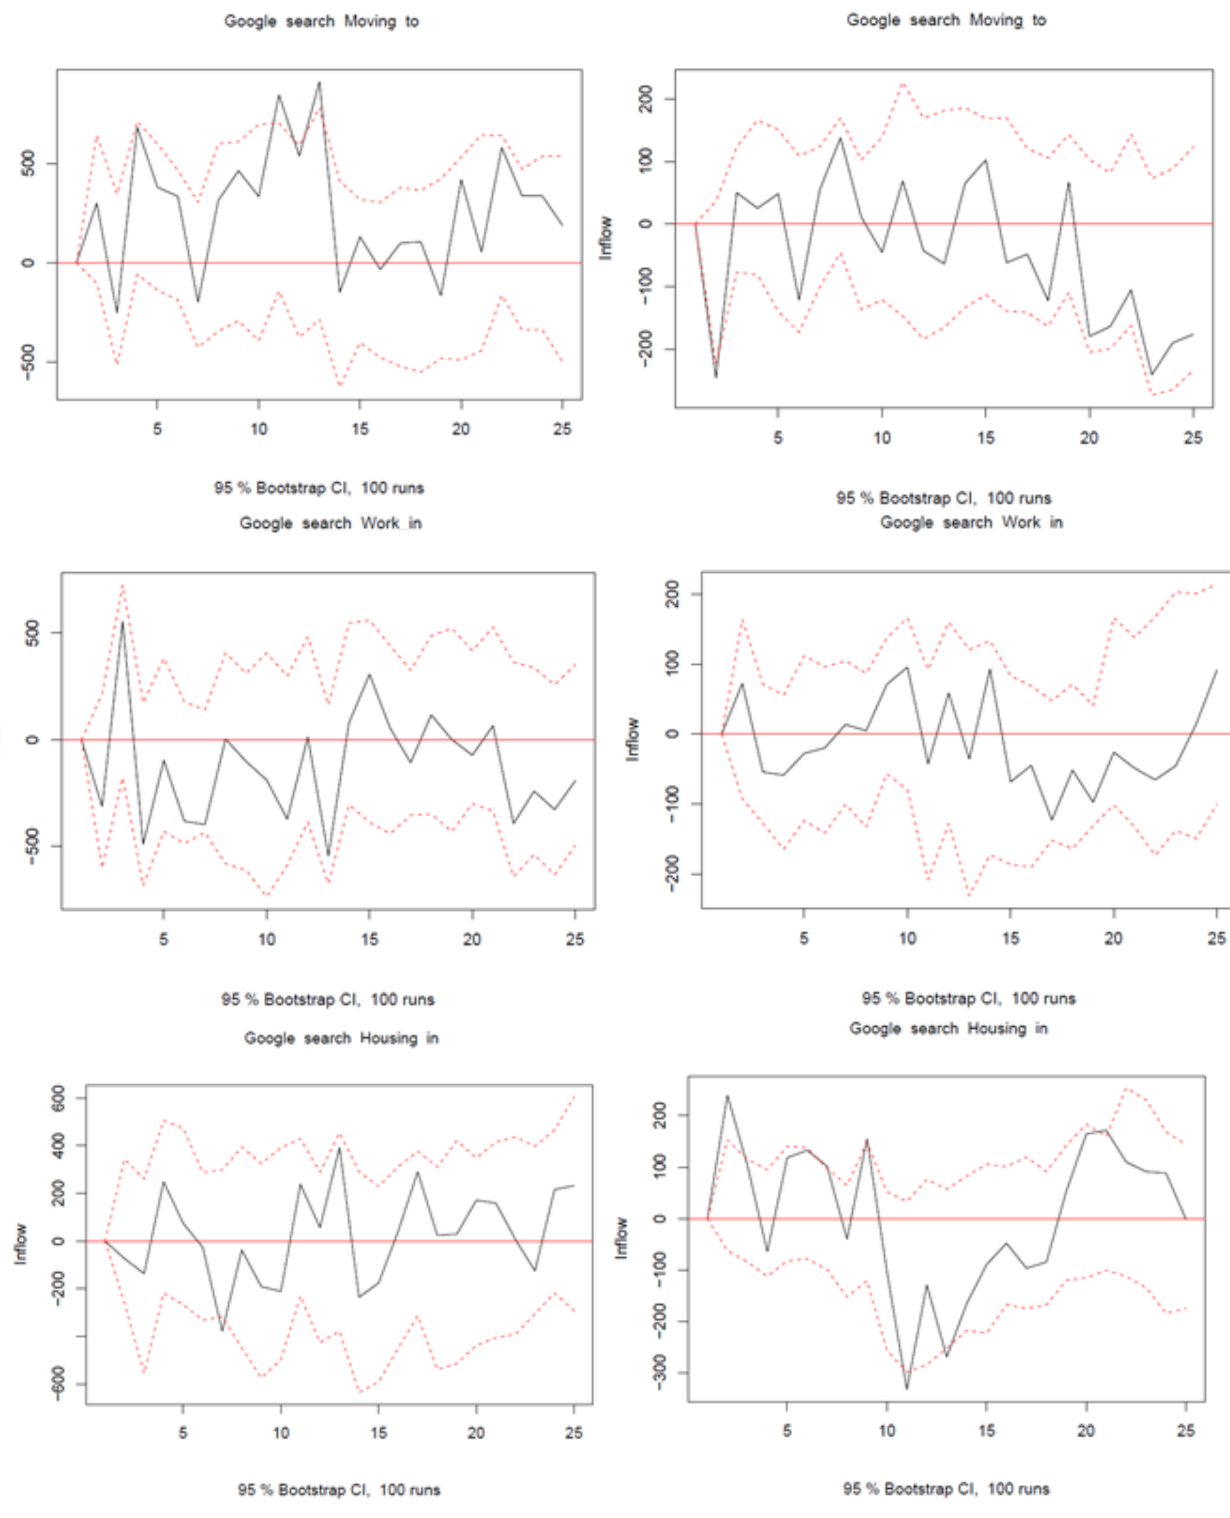
Figure A8. Orthogonal impulse responses from a shock in Google online searches on migration inflow in Moscow (left column) and Saint Petersburg (right column), using a VAR (12) model estimated with the ridge regression estimator.